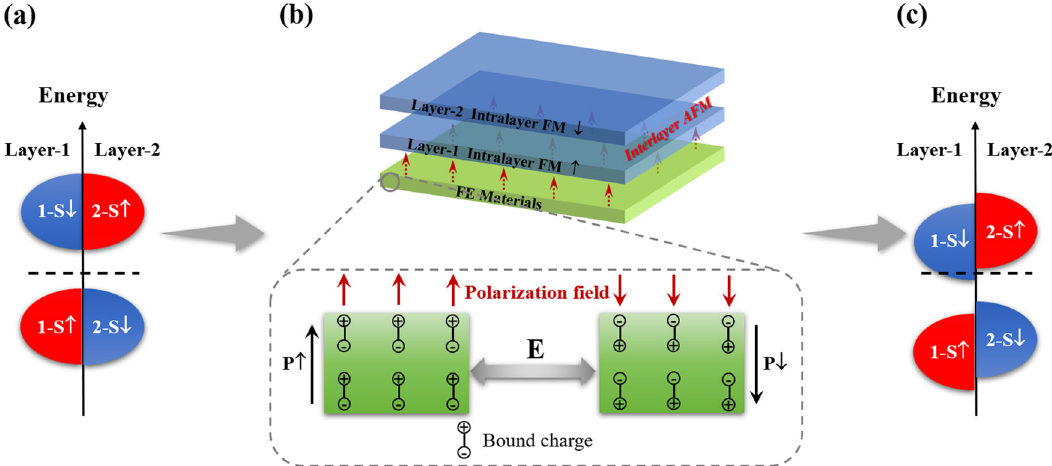
Fig. 1 Principle for realizing half-metallicity. a Schematic illustration of spin- and layer-projected DOS for a bilayer of A-type antiferromagnet. b Diagram of 2D A-type antiferromagnet on FE substrate. c Spin- and layer-projected DOS with